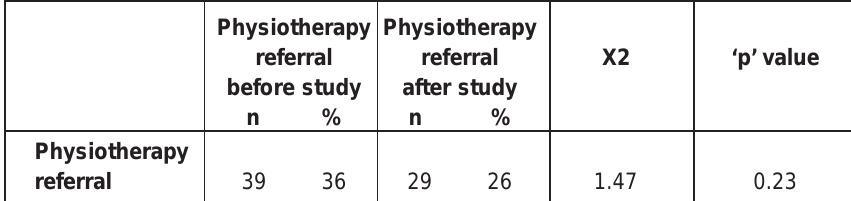
participated in the study, 60 of whom were factory workers and 50 were office workers .The mean age, height,